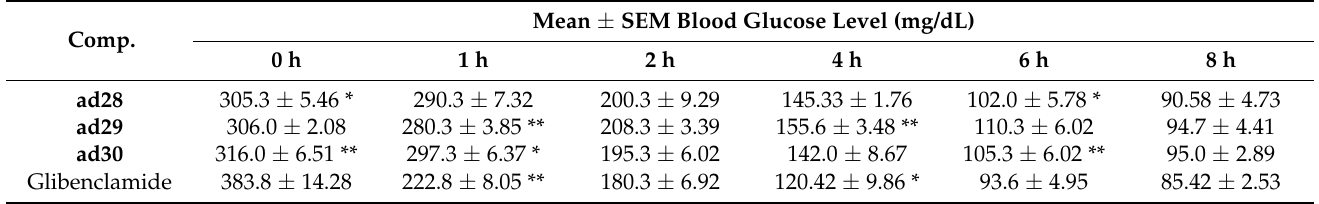
Table 42. Antidiabetic potential of the compounds ( ad28 – ad30 ) in alloxan-induced diabetes in rats.